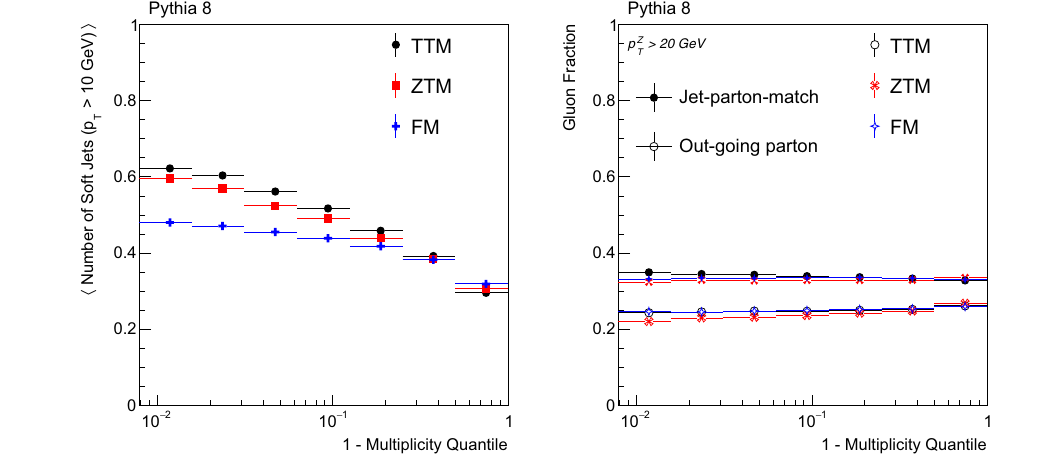
Fig. 6 Left: The number of soft (10GeV < p T , J < 20GeV) jets as a function of the multiplicity quantile for the three multiplicity defini- tions. Right: the gluon composition of the hard jet as a function of the multiplicityquantile.Thereisnouniquewaytodefinethequarkorgluon